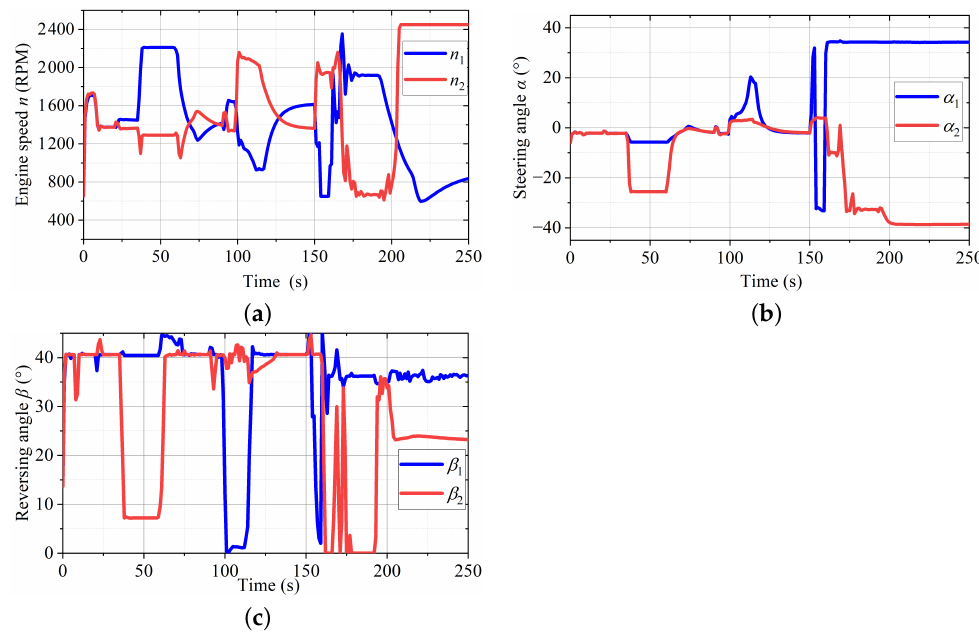
Figure 10. Allocation results of waterjet actuators. ( a ) Engine speed allocation results; ( b ) Steering angle allocation results; ( c ) Reversing angle allocation